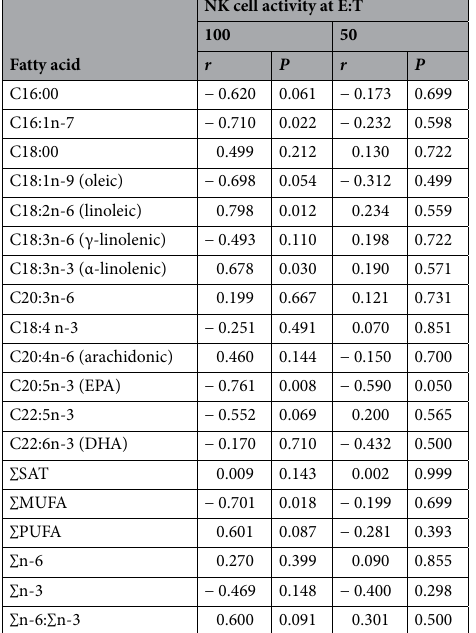
Table 7. Correlation coefficients for the relationships between % of individual fatty acids in the PBMCs and their cytotoxic cell activity. Correlation coefficient ( r ) is Spearman linear rank when data is not normally distributed or Pearson when data is normally distributed. EPA eicosapentaenoic acid, DHA docosahexaenoic acid, DPA docosapentaenoic